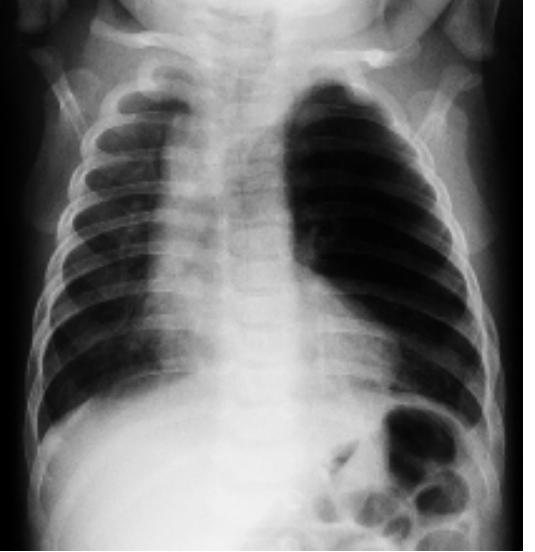
Figure 3 Congenital lobar emphysema (CLE). Chest radiograph of a 4-month-old boy with a CLE in the left upper lobe. The sig- nificantly hyperinflated lobe caused compression of the sur- rounding lung tissue and displacement of the mediastinum. In addition, the patient showed cor triatriatum as an isolated cardiac anomaly.